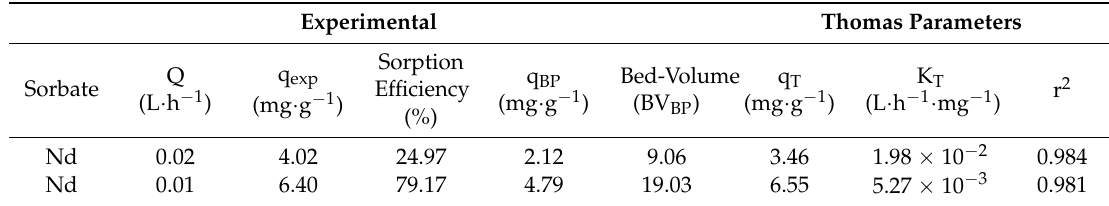
Table 4. Sorption parameters for continuous system using ChiFer(III) material as sorbent. Experimental Thomas Parameters